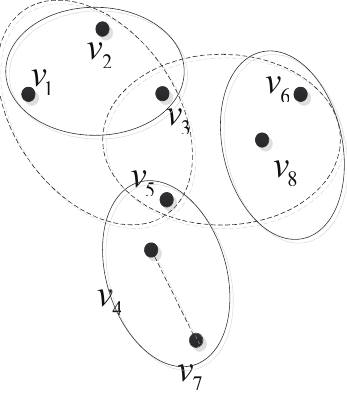
Figure 2. Hypergraph after